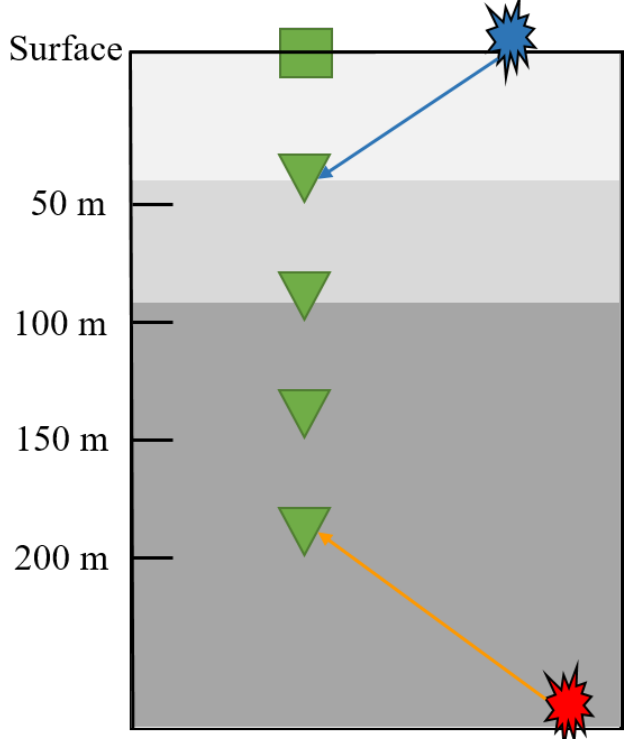
Figure 1. A typical G-network station consisting of an accelerometer at the surface (green square) and four geophones (green triangles). This set up allows the differentiation between genuine seismic events (red) and noise coming from the surface (blue) by observing the moveout pattern across the sensors. Adapted from ref.